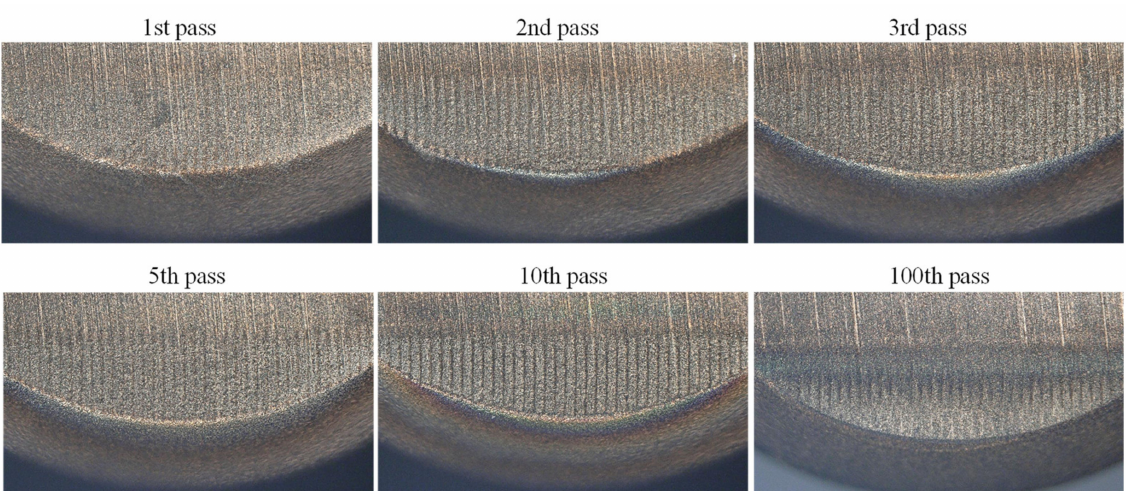
Figure 14. Optical microscope images of the PLG surfaces during the initial processing stage at a pulse pitch of 20 µ m.